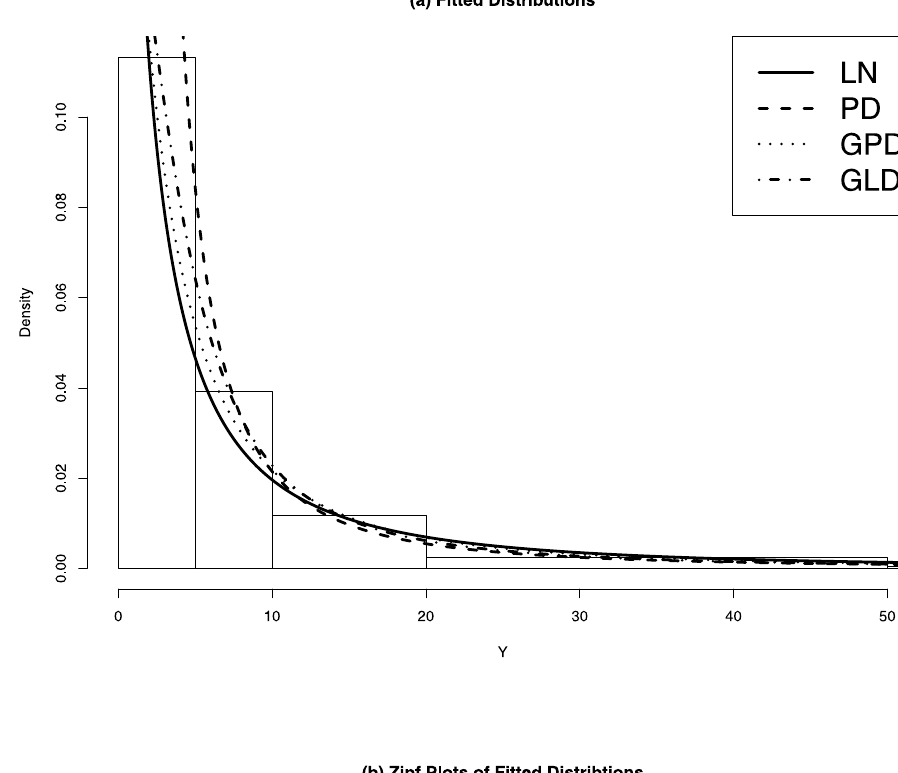
Fig 4. 2014 US private-sector firm size data. Left panel: estimated density functions. Right panel: Zipf plots of the fitted distributions.